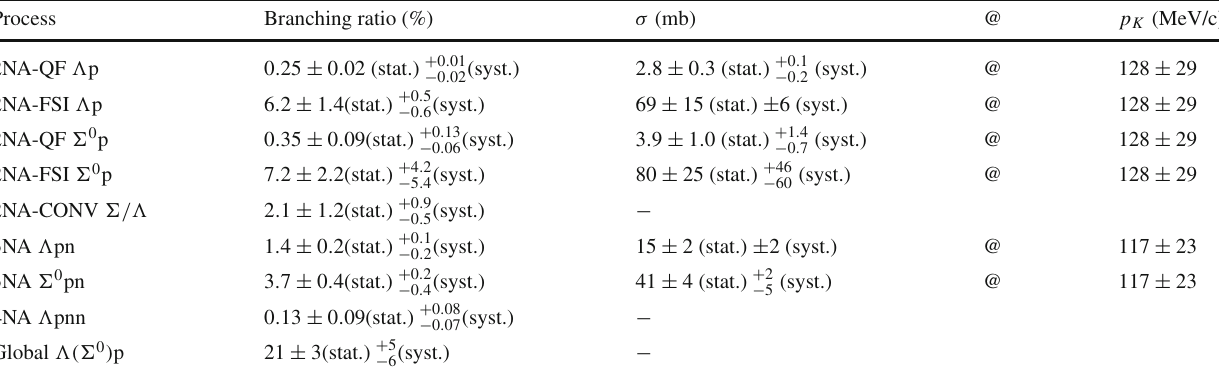
Table 1 Branching ratios (for the K − absorbed at-rest) and cross sec- tions(fortheK − absorbedin-flight)oftheK − multi-nucleonabsorption processes. The K − momentum is evaluated in the centre of mass refer- Process Branching ratio (%)